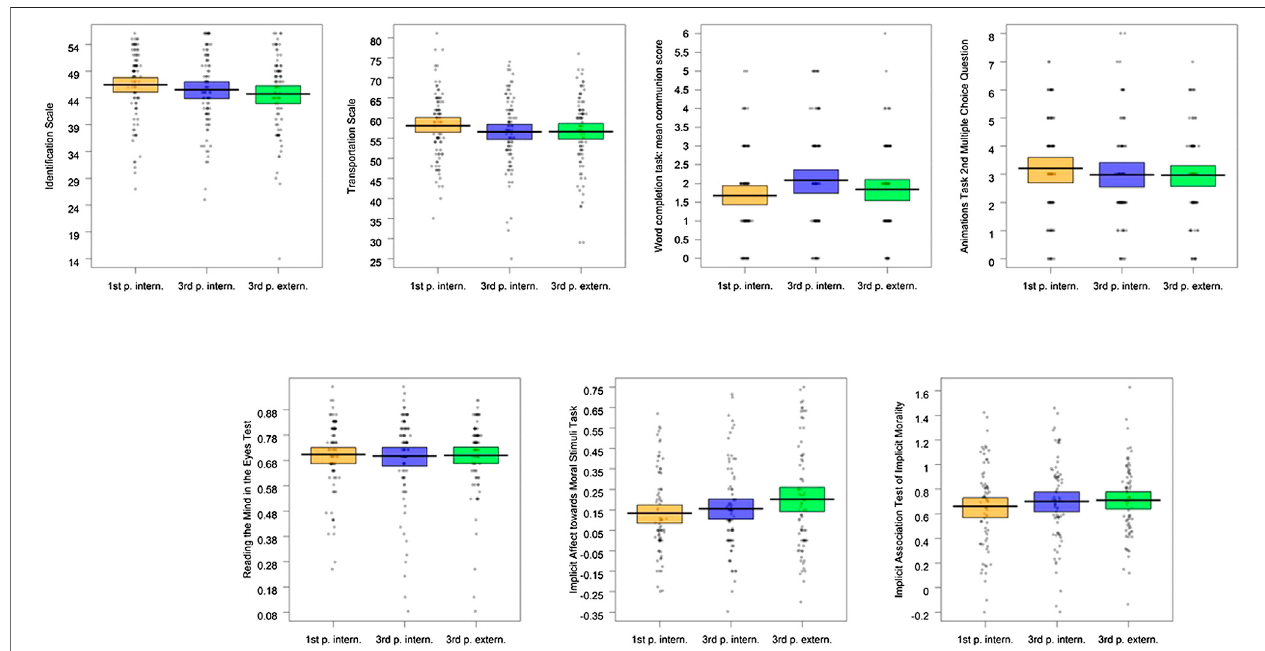
FIGURE 3 | Pirate plots for main outcome variables of Experiment